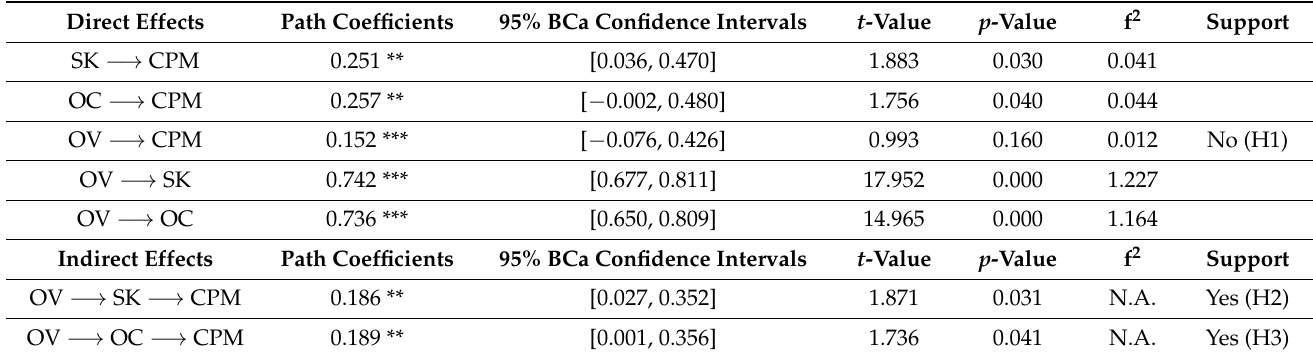
Table 6. Structural model: hypotheses test result.